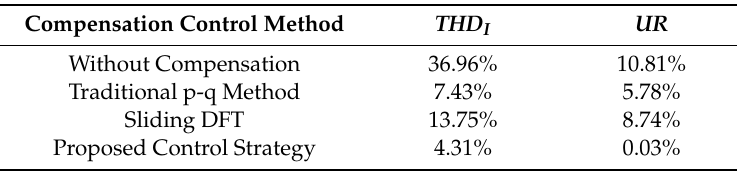
Figure 13. Compensation result with the proposed control strategy for case 2. Table 2. Compensation results for case 2.